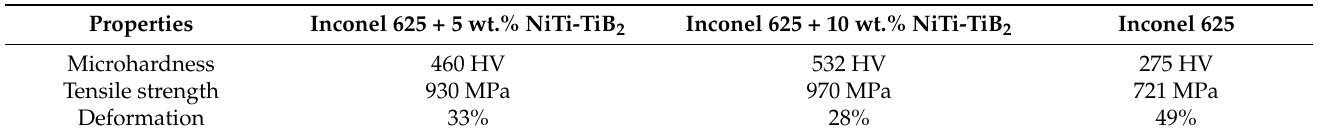
Table 1. Mechanical properties of materials Inconel 625 + 5 wt.% NiTi-TiB 2 , Inconel 625 + 10 wt.% NiTi-TiB 2 and Inconel 625